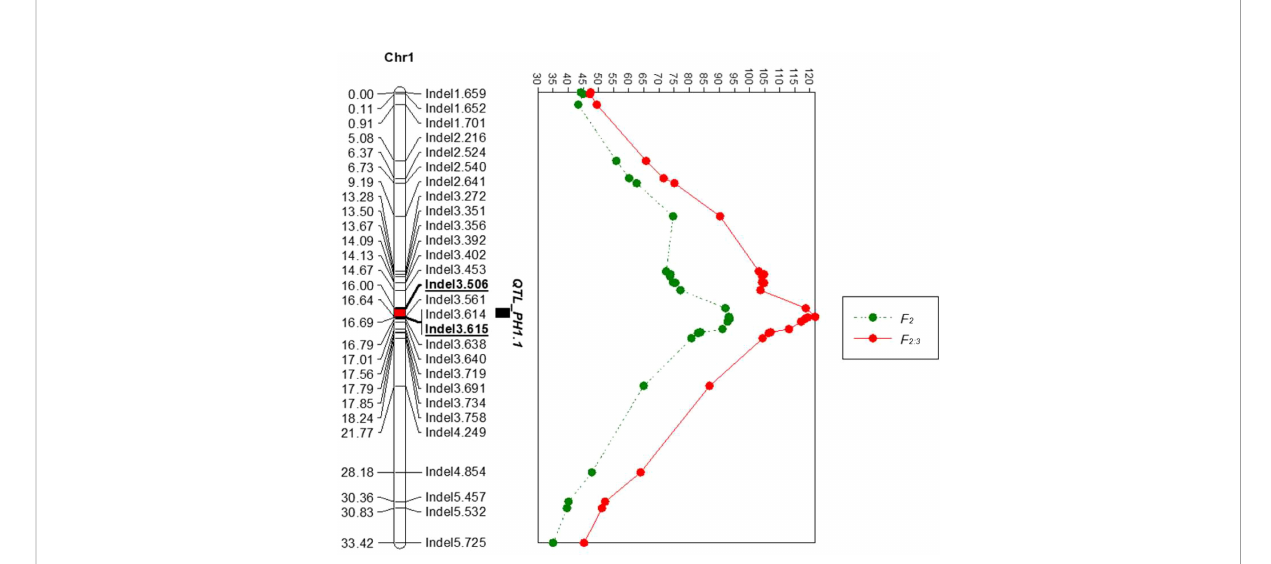
FIGURE 3 Fine-mapping of PH1.1 by linkage analysis. The left panel shows the linkage map, in which the red segment is the fi ne positioning interval of PH1.1 . The right panel displays the log of odds (LOD) value of each locus in the F 2 and F 2:3